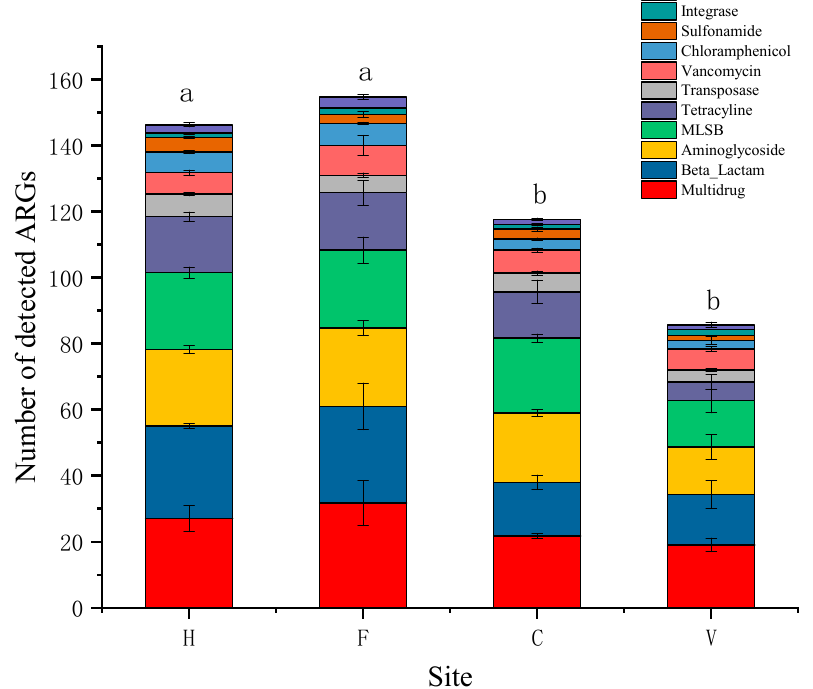
Figure 1. The number of detected antibiotic resistance gene (ARG) types in air-conditioning filters. H: hospital; F: farm; C: city residence; V: village residence. MLSB: macrolide–lincosamide–streptogramin B resistance. Error bars indicate standard errors of three replicates, different lowercase letters indicate a significant difference ( p < 0.05).